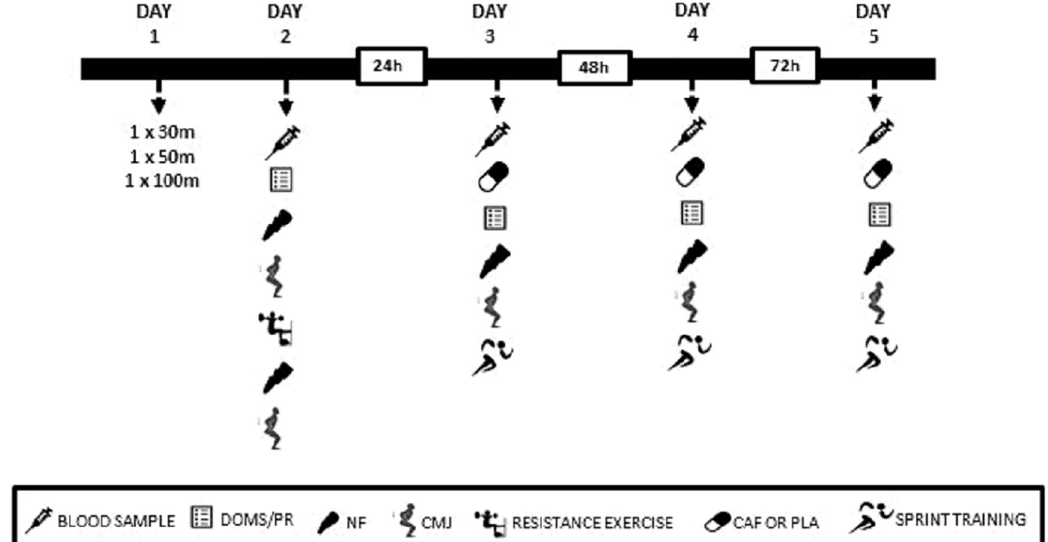
Fig 1. Study timeline. DOMS, Delayed Onset Muscle Soreness; PR, Perceived Recovery; NF, neuromuscular function; CMJ, countermovement jump; CAF, caffeine; PLA, placebo.